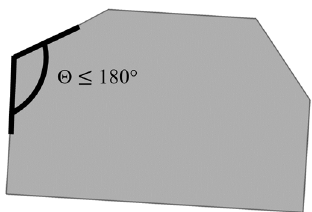
Figure 7. 2D representation of a rigid polyhedral block (all internal angles are less than 180 degrees).